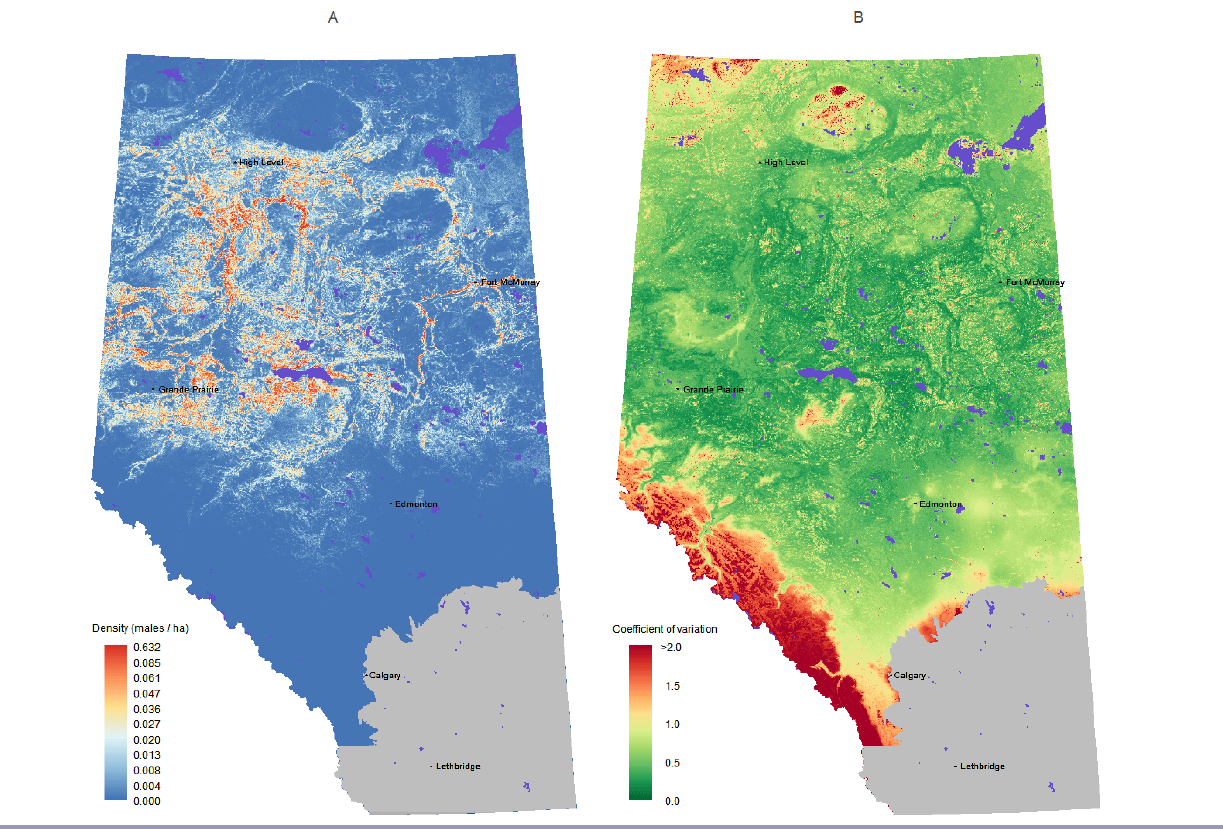
Fig. 4 . Predictive map of bootstrap averaged Canada Warbler density (males/ha) in northern Alberta (A) and the coefficient of variation (B; standard deviation/mean; values are based on 240 bootstrap iterations). The mapping unit is 1 km²; base year for human footprint inventory is 2012.